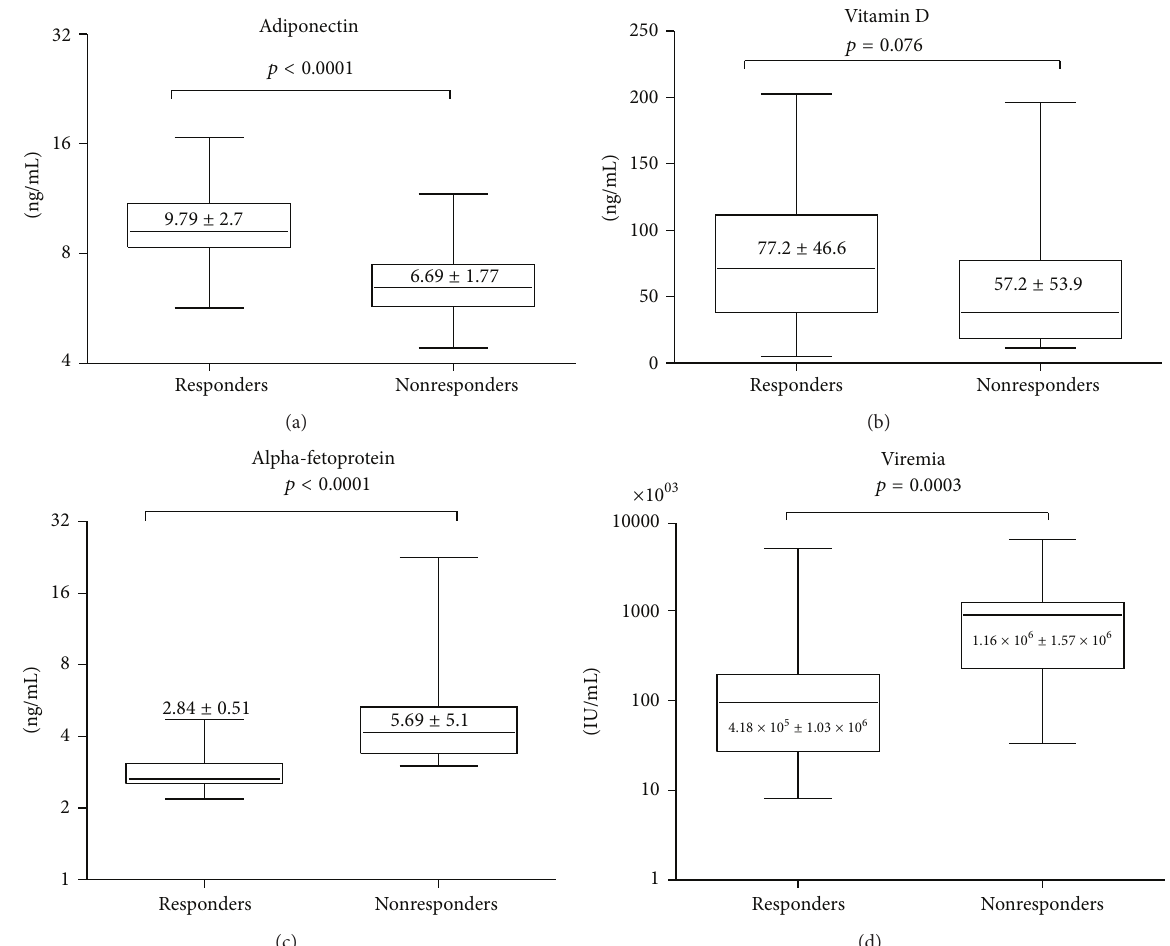
Figure 2: Comparison of pretreatment factors between responders and nonresponders. Box-and-whiskers plot for serum adiponectin, vitamin D, and AFP. The number indicated on the box represents mean ± standard deviation. (a) Adiponectin was significantly ( 𝑝 < 0.0001 ) higher in responders ( 9.79 ± 2.7 ng/mL, range; 5.68–16.68 ng/mL) than nonresponders ( 6.69 ± 1.77 ng/mL, range; 4.4–11.67 ng/mL). (b) Vitamin D was insignificantly ( 𝑝 = 0.076 ) higher in responders ( 77.2 ± 46.6 ng/mL, range; 4.9–202.4 ng/mL) than